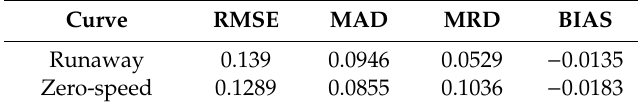
Table 6. Error indexes for runaway and zero-speed curves.